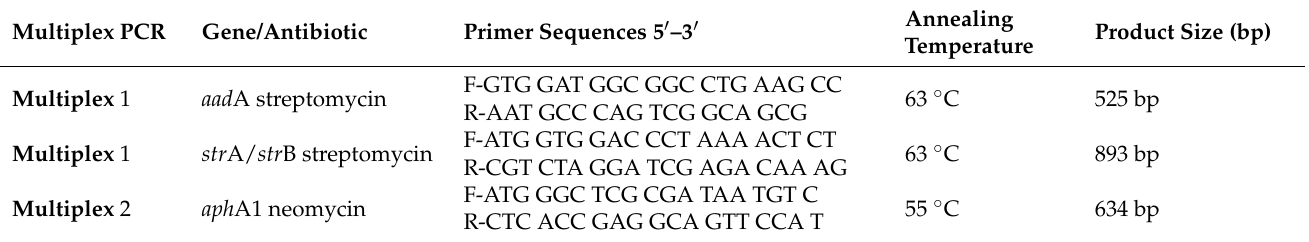
Table 6. Primers sequences for detection of antimicrobial resistance genes in the Salmonella spp. isolate and multiplex PCR annealing temperature (based on